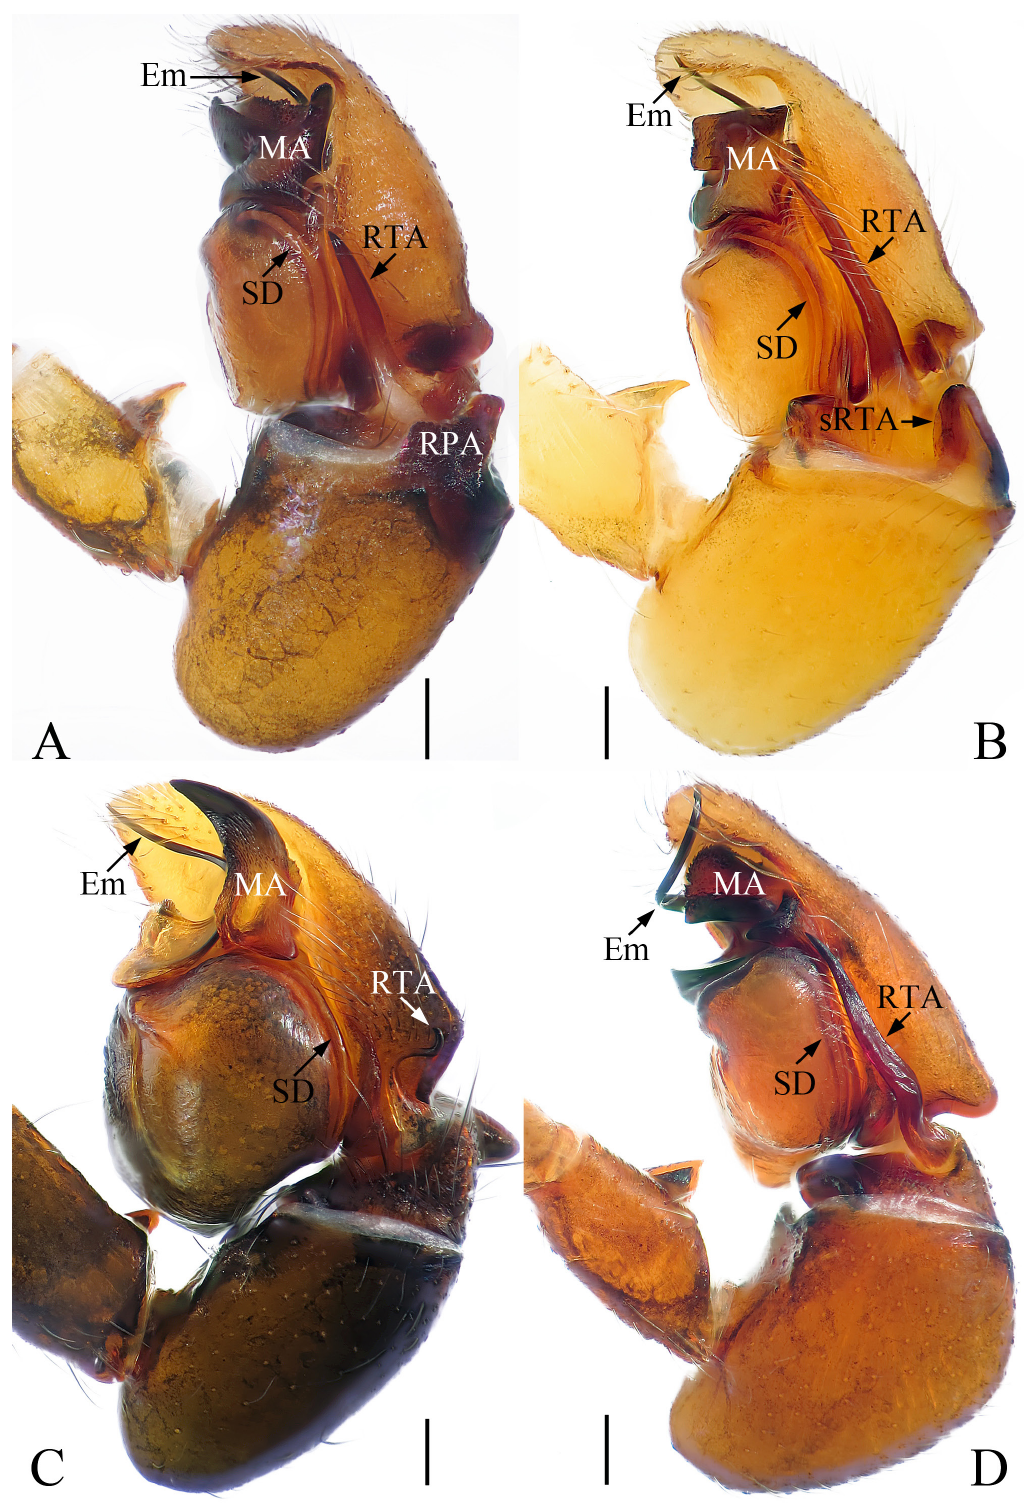
Fig. 17. Male palp of Synagelides spp. A , C . Holotype, retrolateral view. B , D . Male, retrolateral view. A . S. logunovi sp. nov. (TRU-Salticid-0016). B . S. forkiforma Yang, Zhu & Song, 2007 (HNU-20040428- 01). C . S. bohdanowiczi sp. nov. (TRU-Salticid-0010). D . S. palpalis Żabka, 1985 (TRU-Salticid-0053). Abbreviations: see Material and methods. Scale bars = 0.1